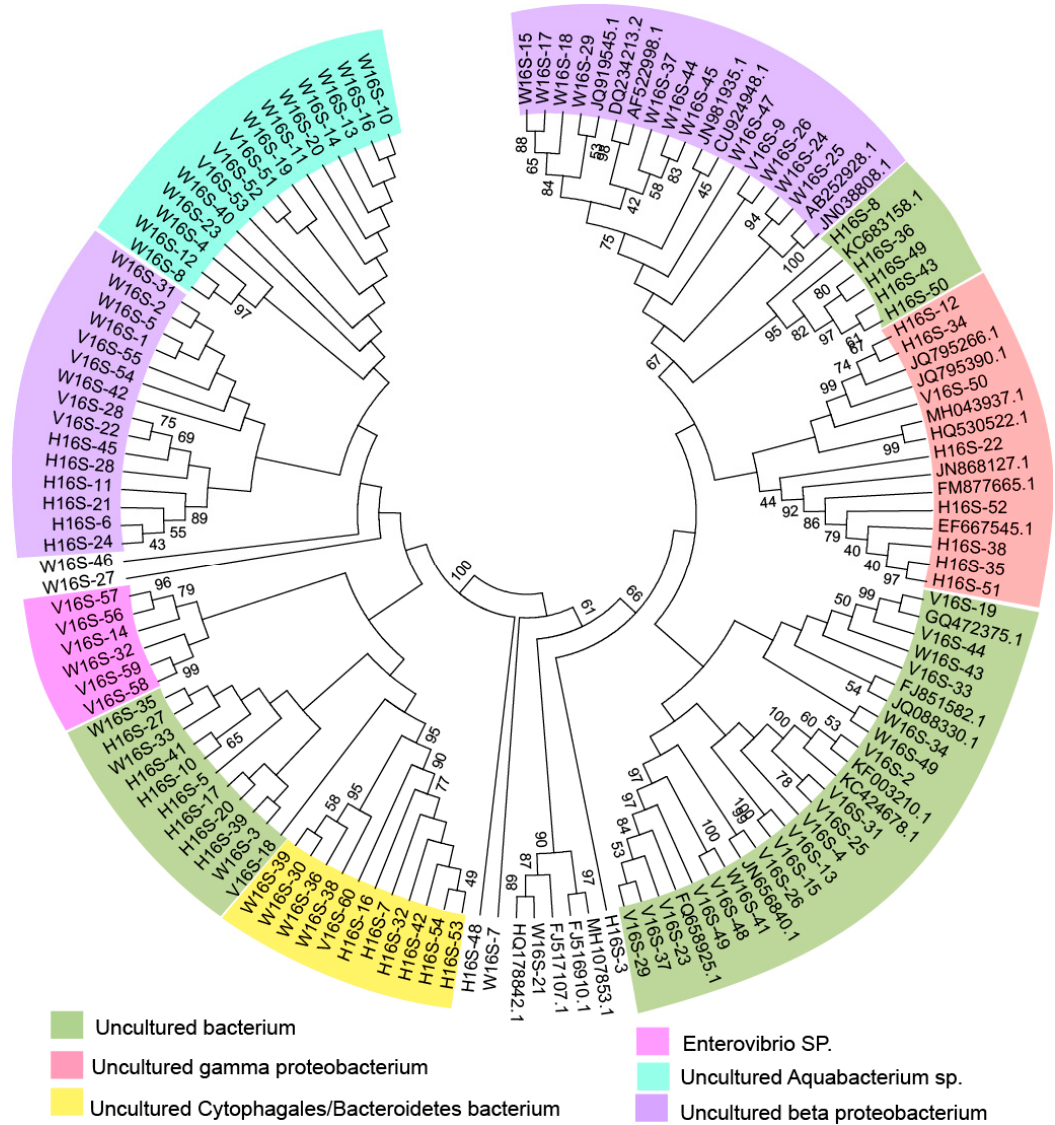
Figure 1. Analysis of microbial communities based on 16S rRNA partial gene sequences retrieved from three environmental collections and other representative organisms’ species. Clones H16S, V16S, and W16S were from a high ‐ quality Qingshan Lake water site (QL ‐ H), the Qingshan Lake site closest to the village (QL ‐ V), and domestic pollution in the Sludge River (SR ‐ W), respectively.